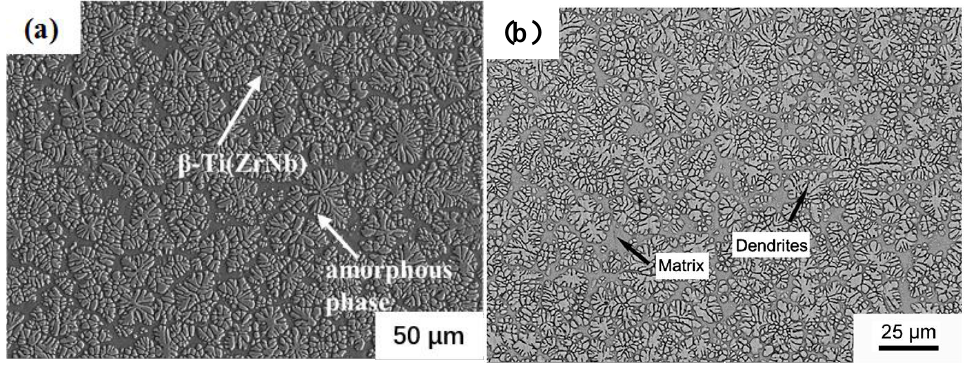
Figure 2. Microstructure morphologies ( a ) after 20 cycles of treatment and ( b ) without treatment [26].